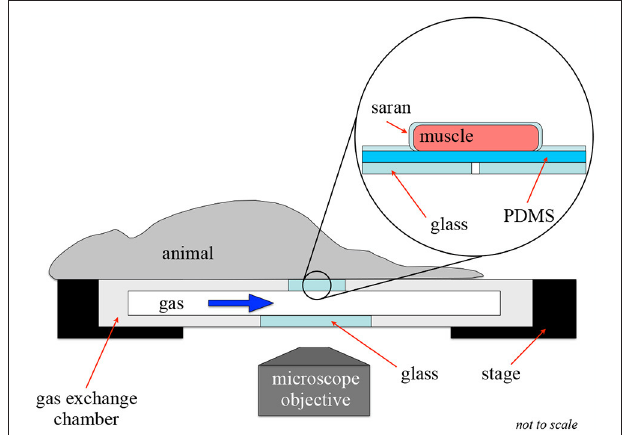
FIGURE 2 | Intravital video microscopy experimental setup. This figure shows the experimental setup for an intravital experiment to allow for oxygen exchange to a localized area of tissue. In this setup, the muscle is extended over the gas exchange window and covered in gas-impermeable Saran wrap to isolate the muscle from the surrounding environment.